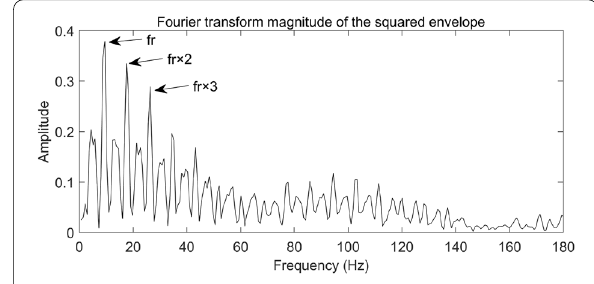
Figure 24 The squared envelope spectrum of the processed signal based on the maximum kurtosis